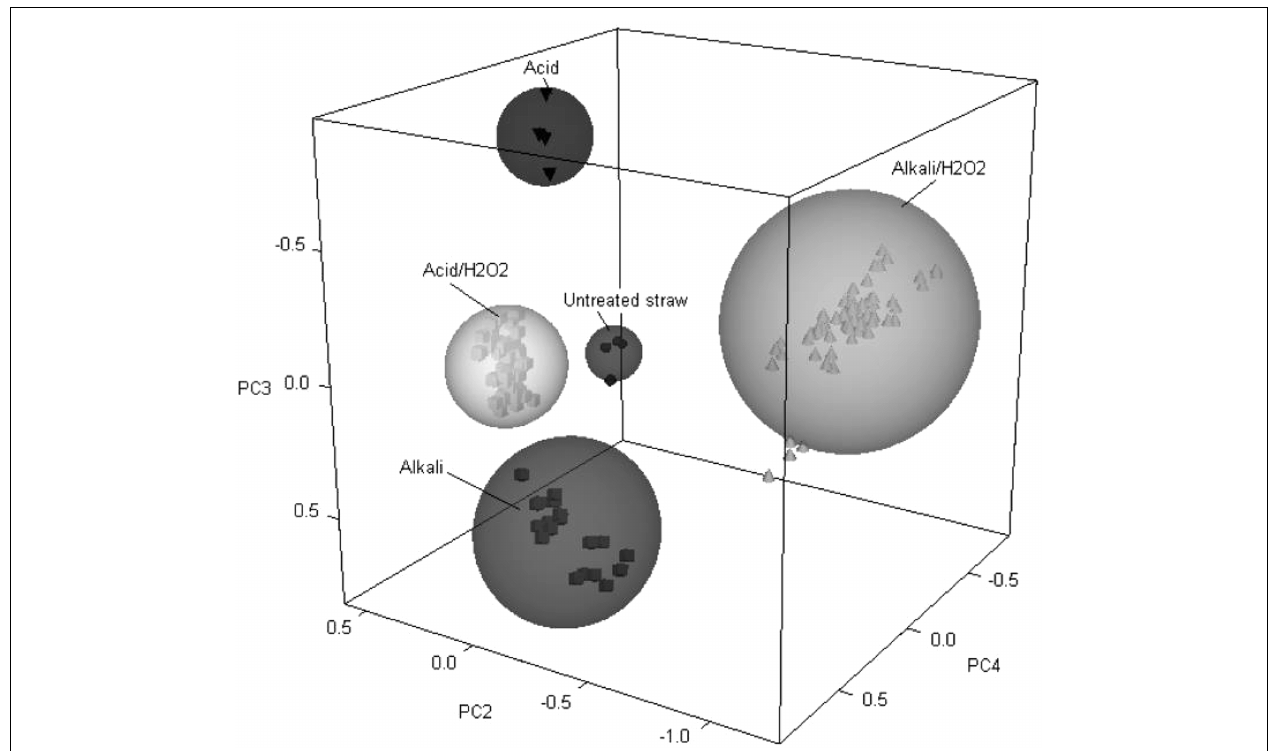
FIGURE 1 | PCA scores plot of untreated wheat straw samples ( • ) and samples treated with acid ( (cid:2)(cid:2)(cid:2) ), alkali ( (cid:3)(cid:3)(cid:3) ), acid/H 2 O 2 ( (cid:4)(cid:4)(cid:4) ), and alkali/H 2 O 2 ( (cid:2) ) as reproduced from literature (Krongtaew etal.,